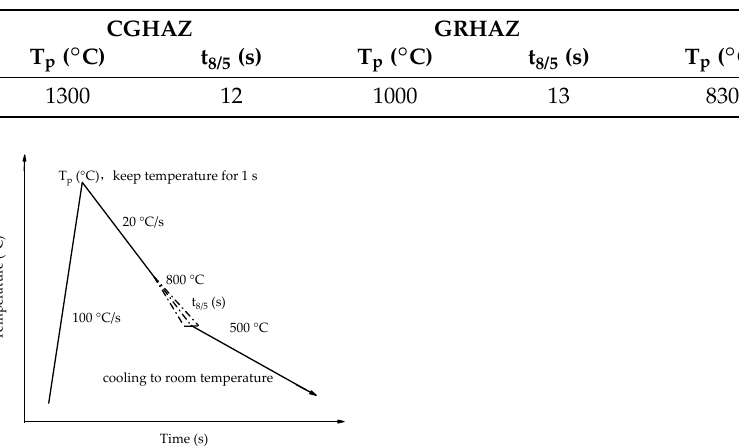
Table 3. Experiment parameters of weld simulation.